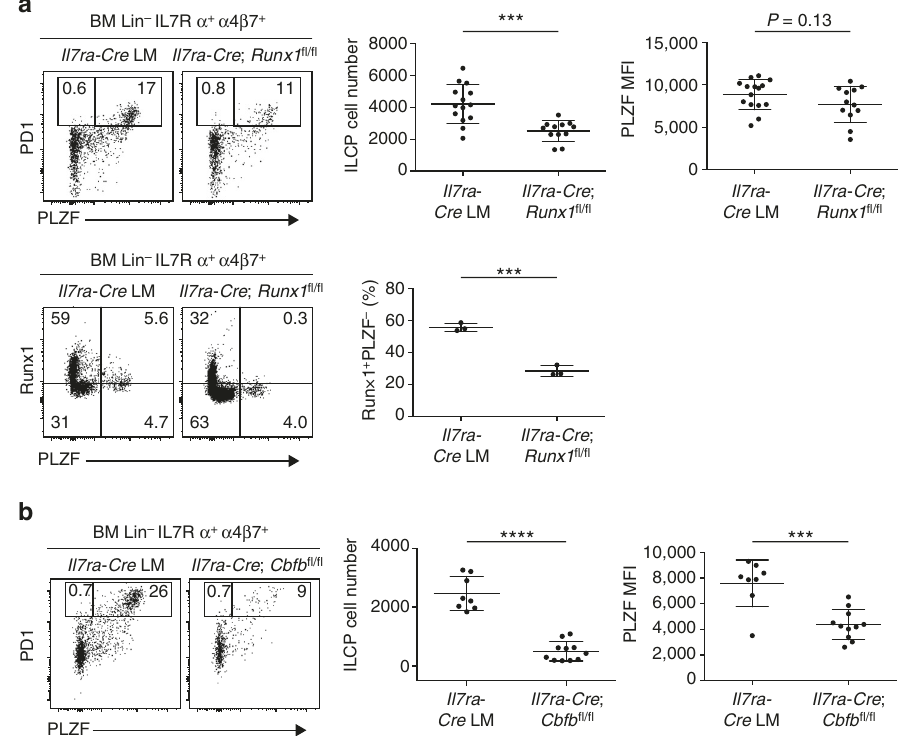
Fig. 8 Conditional ablation of Runx1 in ILCP. a Top PLZF expression in BM Lin - IL7R α + α 4 β 7 + cells from Il7ra - Cre and Il7ra - Cre Runx1 fl / fl . BM samples were MACS-enriched using anti- α 4 β 7 antibody before staining with other antibodies. Summary data of ILCP cell number and PLZF mean fl uorescence intensity of ILCP cells are combined from seven independent experiments with 15 and 12 mice in each group. Bottom, Runx1 and PLZF staining in BM Lin - IL7R α + α 4 β 7 + cells from Il7ra - Cre and Il7ra - Cre Runx1 fl / fl . Data are representative of three mice from each group. b PLZF expression in BM Lin - IL7R α + α 4 β 7 + cells from Il7ra - Cre and Il7ra - Cre Cbfb fl / fl . Data are summarized from four independent experiments, with 8 – 11 mice in each group. Statistical analysis